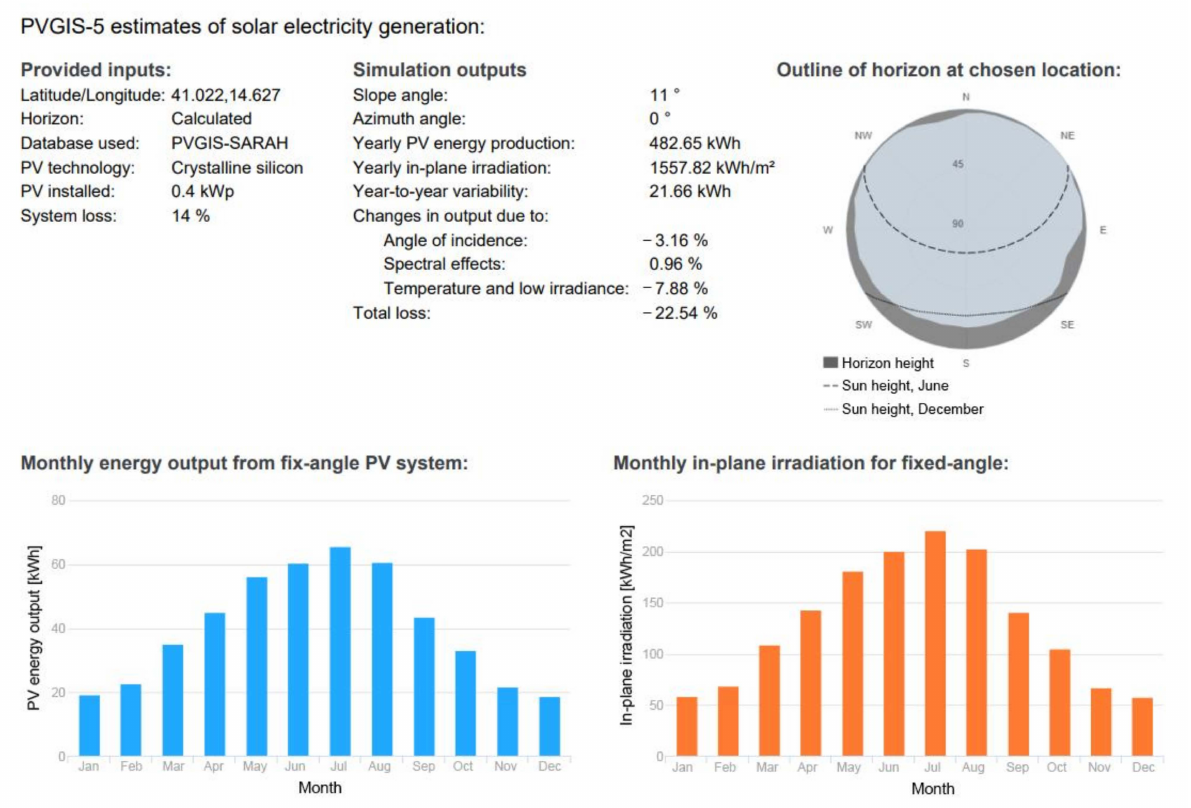
Figure 9. Output data by PVGIS simulator.